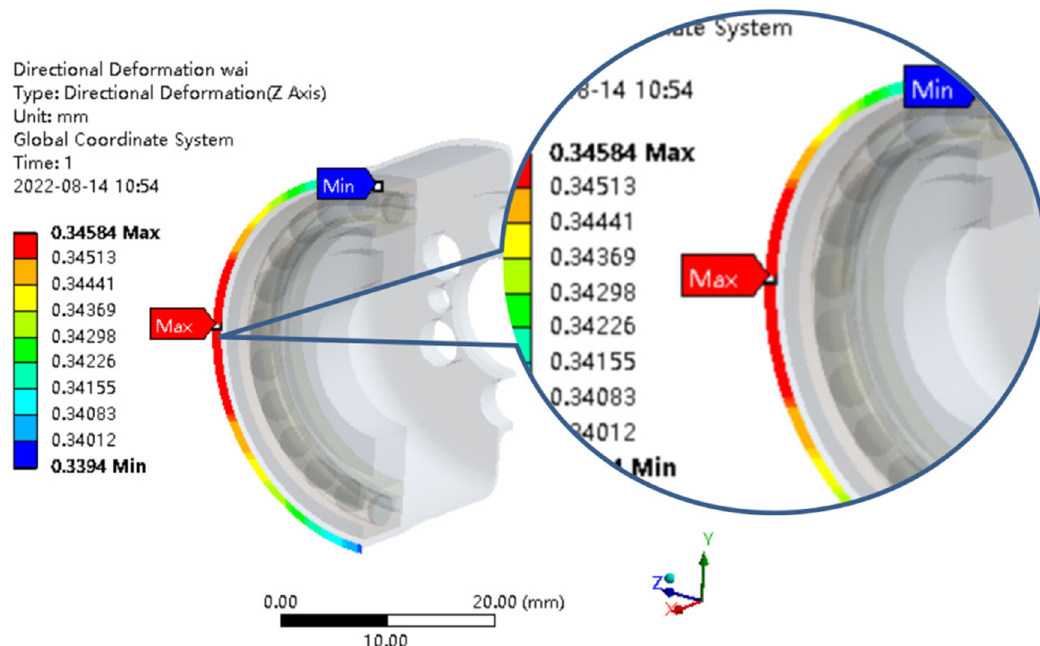
Figure 11: Radial deformation of outer surface of FS.